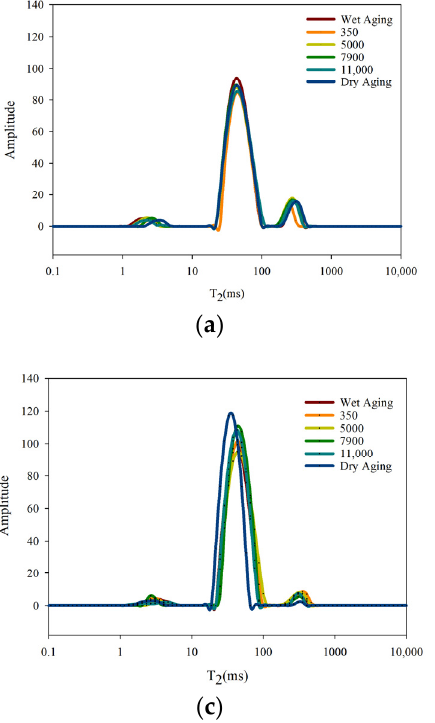
Figure1. ( a )low-fieldNMRT 2 relaxationcurvesofagedbeefwithdi ff erenttreatments(0d); ( b )low-field Figure 1. ( a ) low-field NMR T 2 relaxation curves of aged beef with different treatments (0 d); ( b ) NMR T 2 relaxation curves of aged beef with di ff erent treatments (7 d); ( c ) low-field NMR T 2 relaxation low-field NMR T 2 relaxation curves of aged beef with different treatments (7 d); ( c ) low-field NMR curves of aged beef with di ff erent treatments (14 T 2 relaxation curves of aged beef with different treatments (14 d).